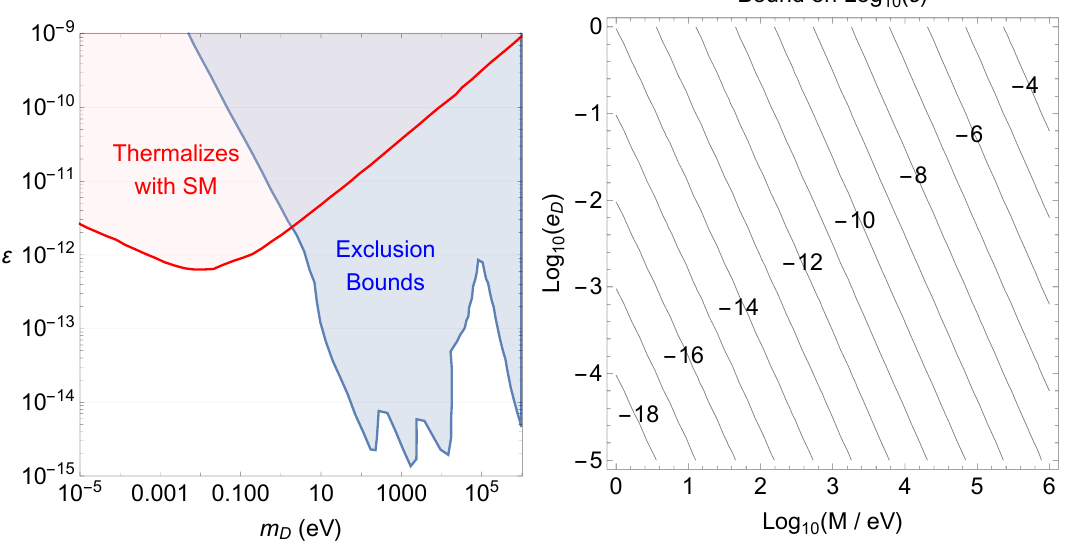
Figure 1 . Left: Excluded region, in blue, for the kinetic mixing parameter " as a function of the dark photon mass m D . These bounds come primarily from stellar cooling and the late decays of dark photons into visible photons. The red region indicates the dark photon thermalizes with the SM [28]. Right: Bound on Log " from magnetar lifetimes as a function of M and e D , see 10